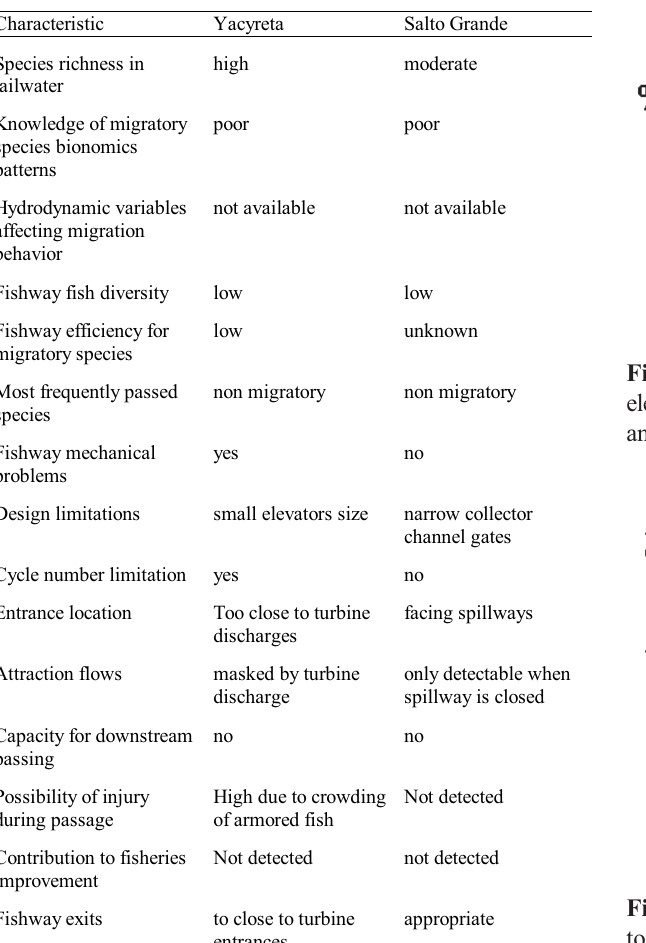
Table 1. Primary fishway characteristics at Yacyreta and Salto Grande dams.